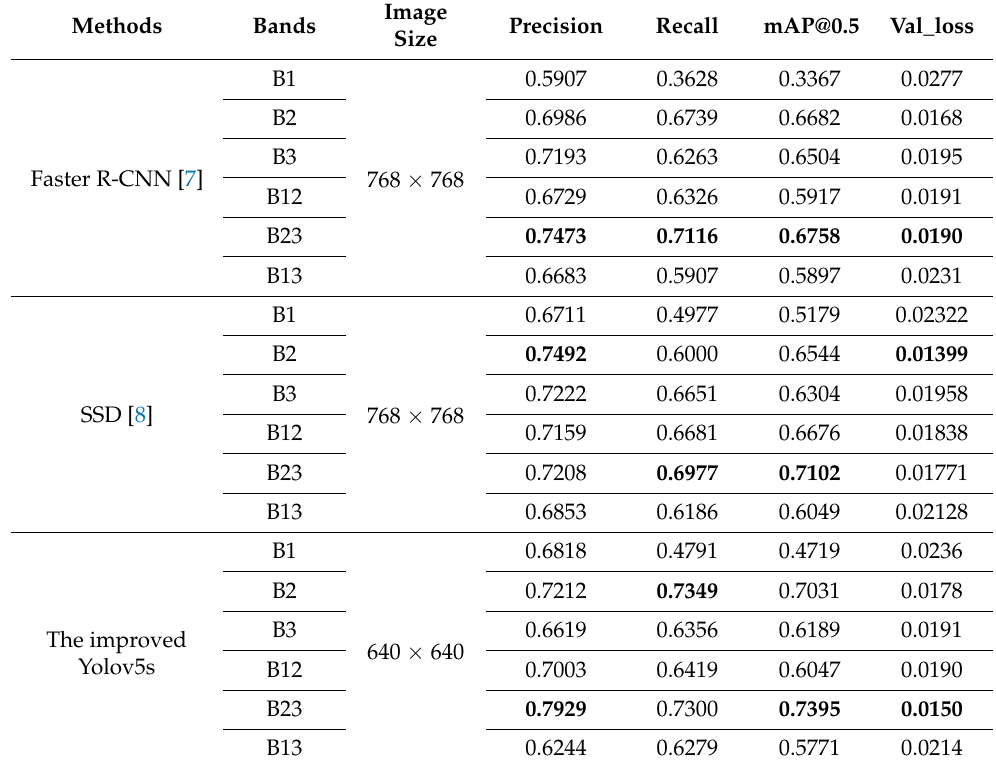
Table 6. Detection evaluation criteria of single band and combined bands images in the TISD by several models (The bold data is the best result of the each model).